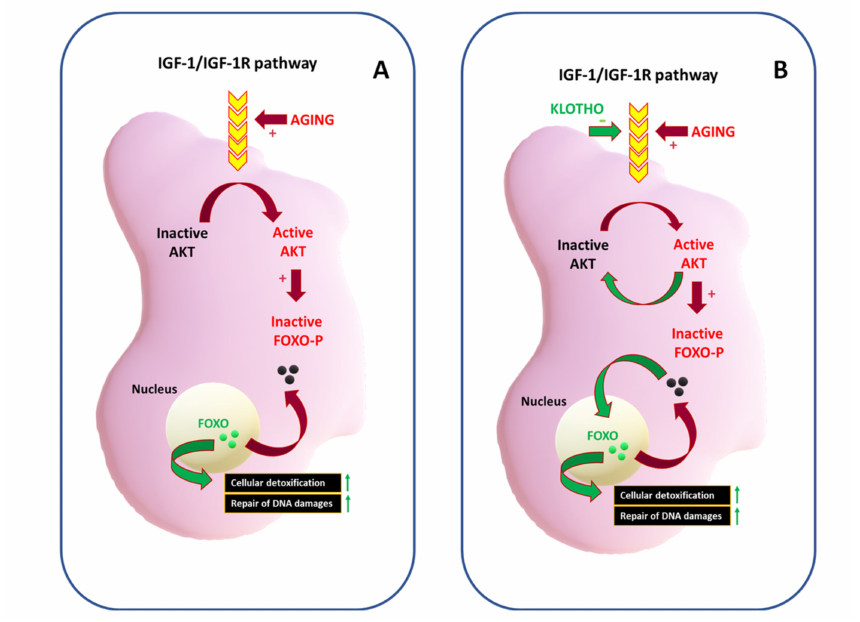
Figure 3. Role of FOXO ( A ) and KLOTHO ( B